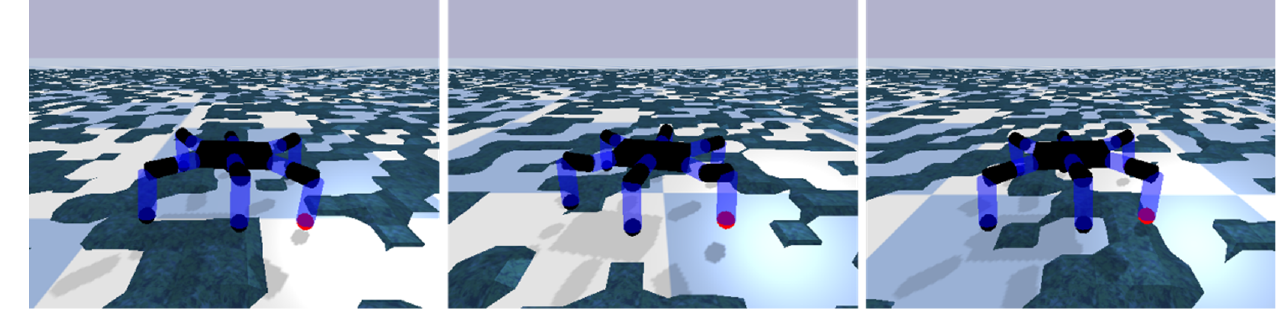
Figure 7. The hexapod robot uses the RL-CPG algorithm to walk on rough ground. During motion, the roll and pitch angles reflect the degree of body sway. Figure 8 records the roll and pitch angles during the movement of the robot using RL-CPG algorithm. The results show that the shaking amplitude of the robot is about 3 degrees, and the performance is smooth. This also indicates that the proposed terrain-adapted gait generator is feasible and capable of making the hexapod robot move in rough